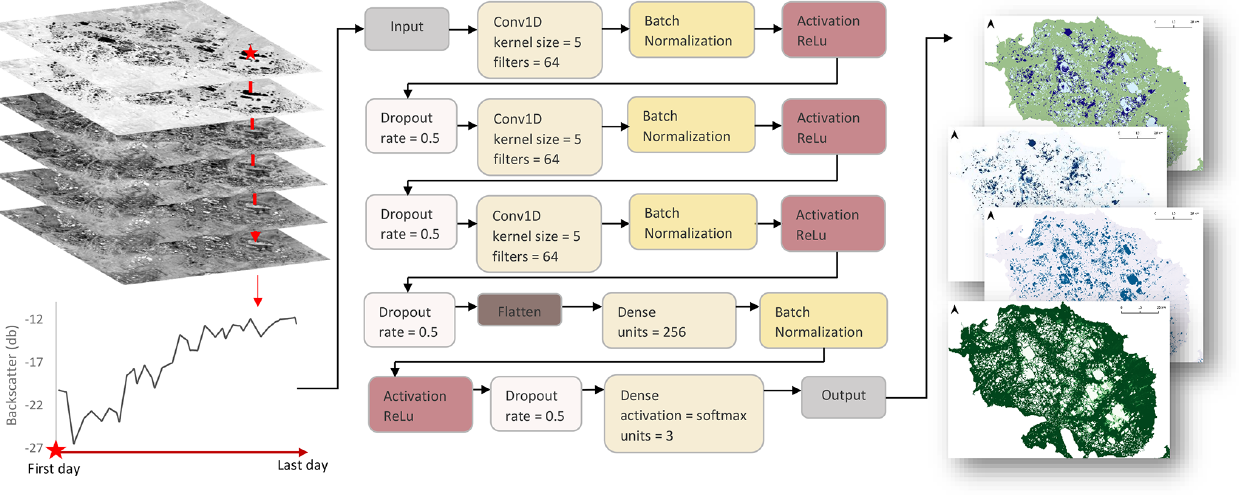
Figure 4. Structure of the trained TempCNN. The left portion represents an image stack that serves as an input to the neural network; the middle portion illustrates the composition of the TempCNN including layers, activation functions, and mechanisms for overcoming overfitting; the right portion represents the output created by the neural network that consists of a three-class (floating ice, bedfast ice, land) map and three probability maps (one for each